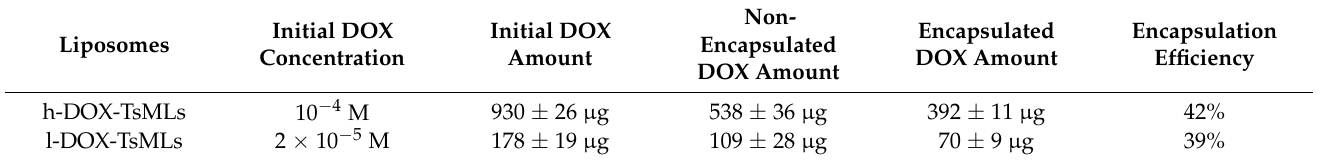
Table 1. Loading capacity of TsMLs with